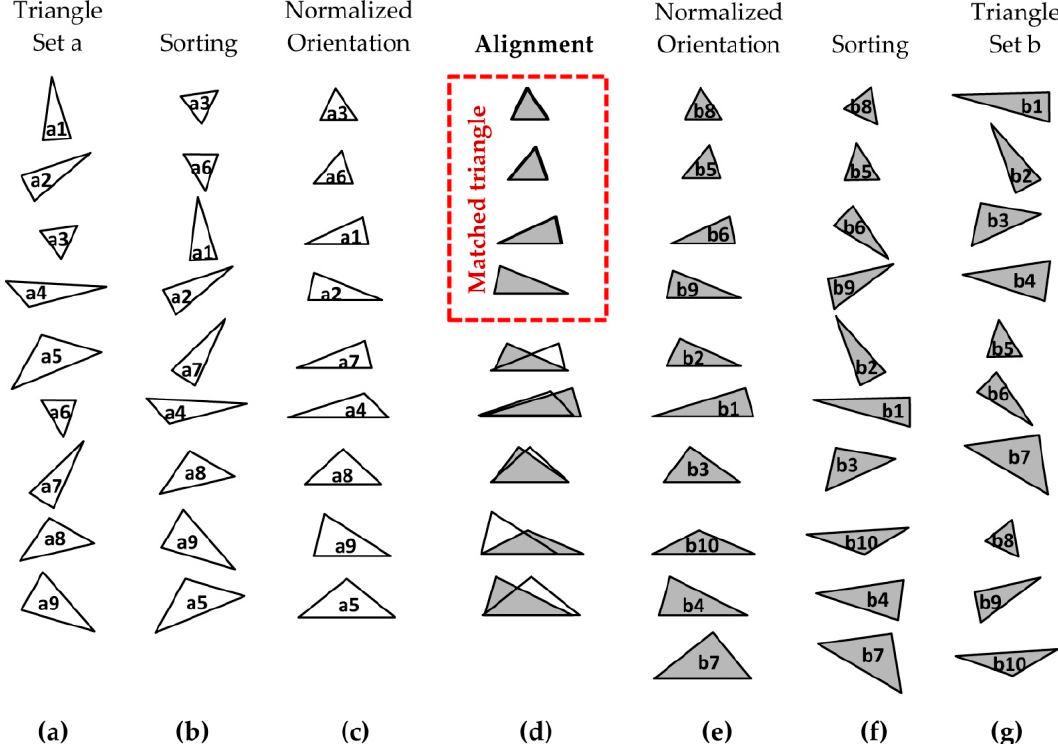
Figure 16. Matching in the case of rigid transformation. ( a ) Set of triangles of vein pattern minutiae of the template. ( b ) Sorted ( a ) in ascending order. ( c ) Reorientation of ( b ) in a normalized position. ( g ) Set of triangles of vein pattern minutiae of the unknown. ( f ) Sorted ( g ) in ascending order. ( e ) Reorientation of ( f ) in a normalized position. ( d ) Matching triangles between ( c ) and ( e ).